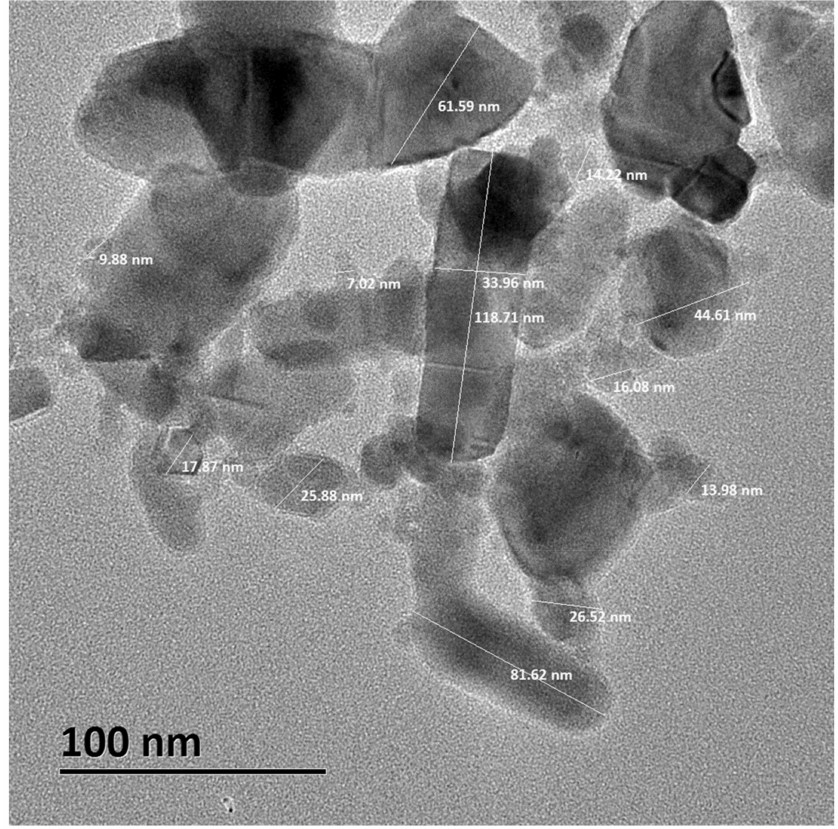
Figure 2. Size analysis of ZnO NPs by TEM. Microphotograph shows the different sizes of nanometric crystals in the